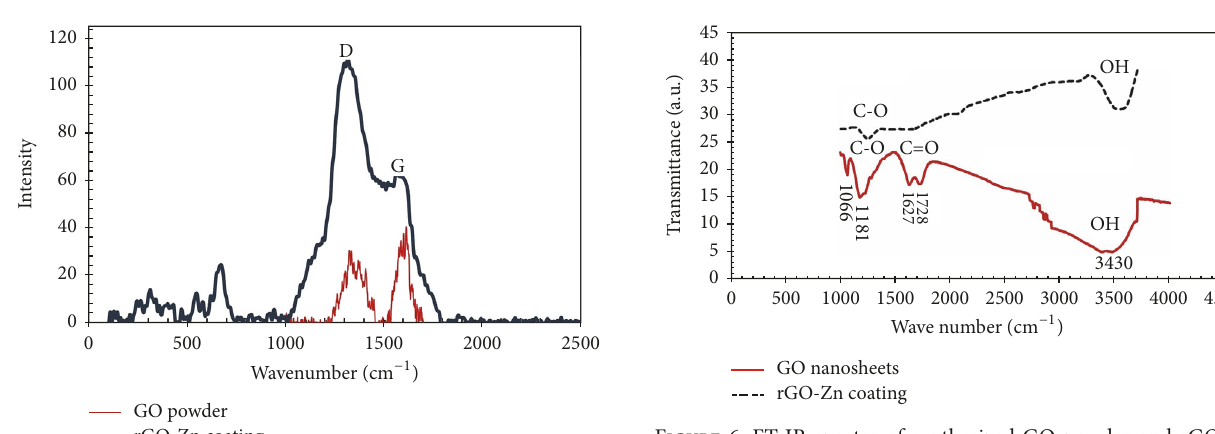
Figure 6: FT-IR spectra of synthesized GO powder and rGO-Zn coating produced by pulse-potential electrodeposition